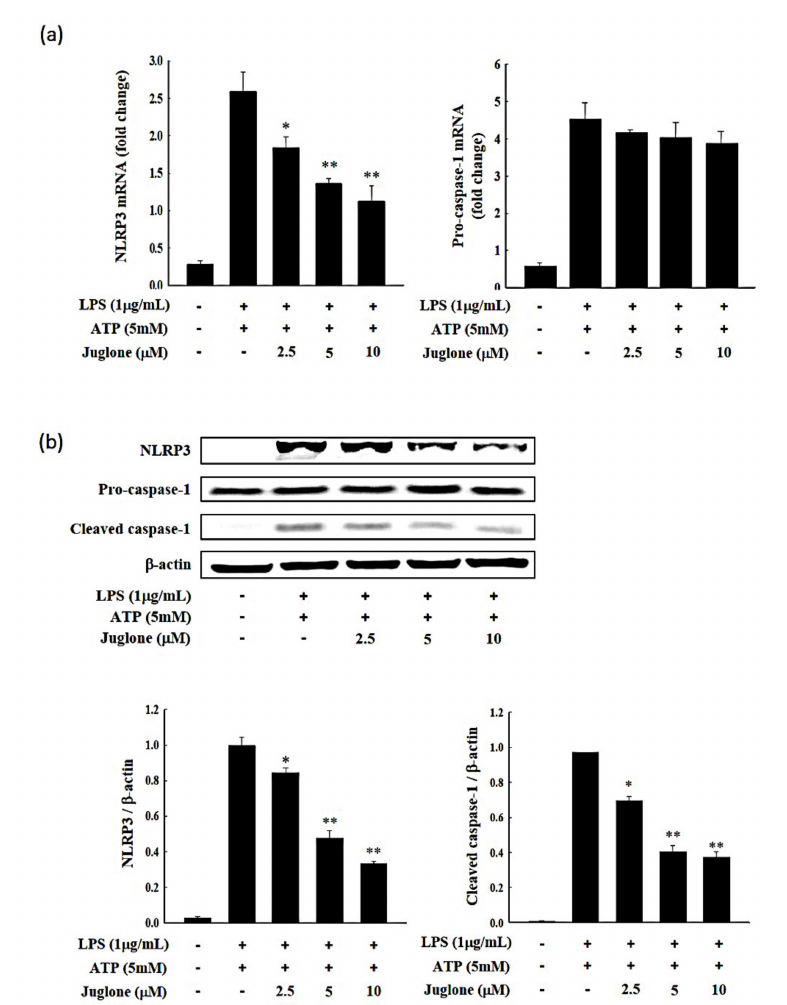
Figure 4. J774.1 cells were treated with various concentrations of juglone for 2 h and then treated with 1 µ g / mL LPS for 24 h. ( a ) The mRNA levels of NACHT, LRR and PYD domains-containing protein 3 (NLRP3) and caspase-1 in J774.1 cells were determined by RT-qPCR. GAPDH was used as a reference gene. ( b ) The relative protein levels of NLRP3, procaspase-1, and cleaved caspase-1 were assessed by Western blotting and are presented as relative to β -actin intensity. Data are presented as the mean ± SD.* p < 0.05; ** p < 0.01 vs. LPS + ATP treated